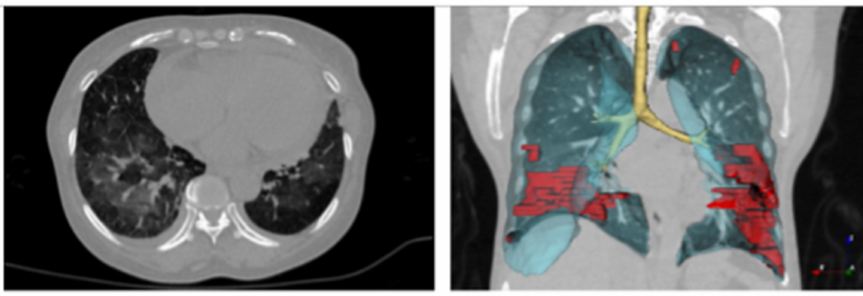
Figure 3. Samples of digital images. Source: